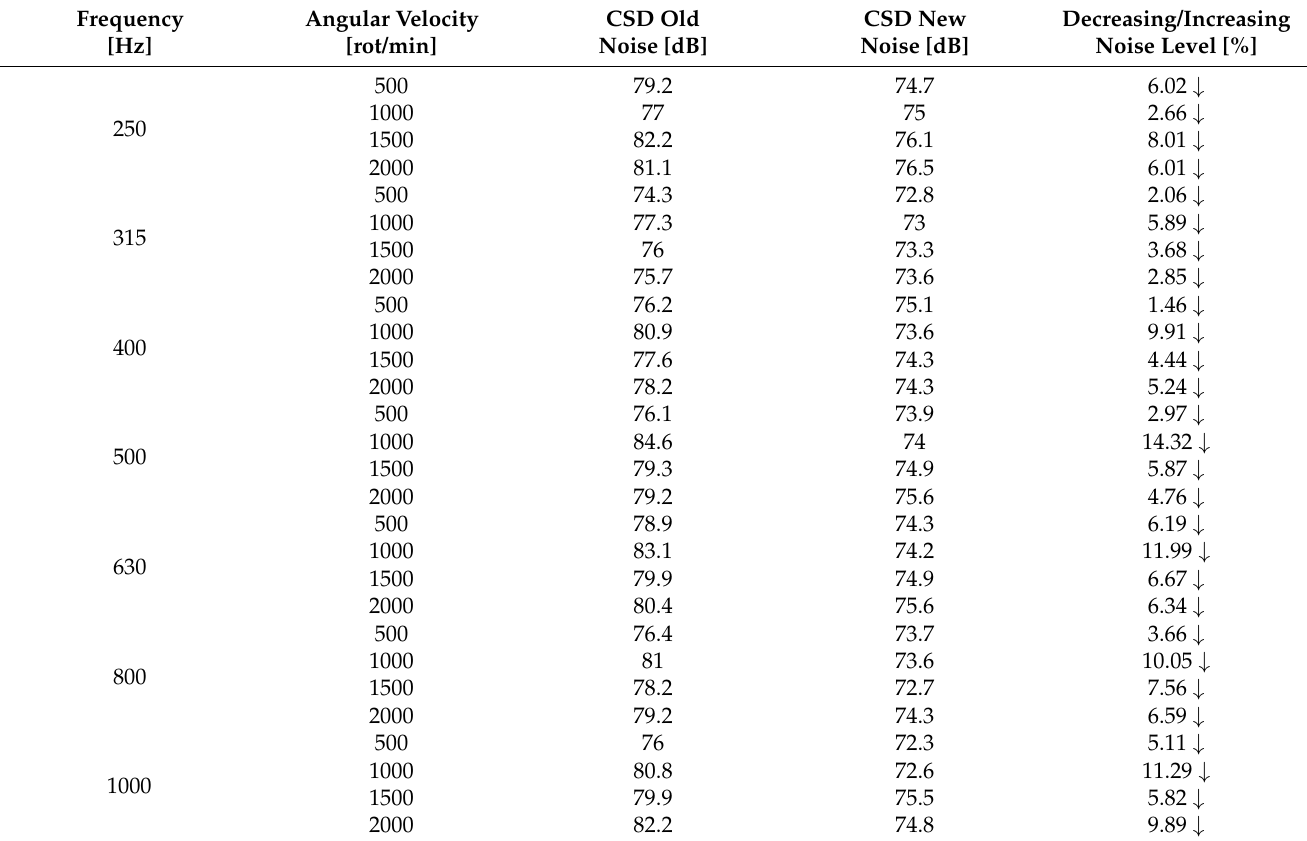
Table A6. Noise level on the lateral left surface of